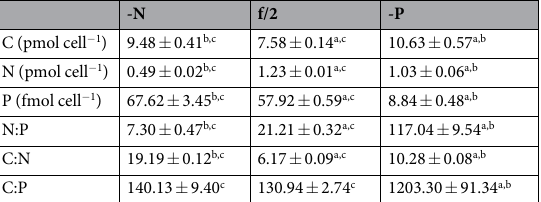
Table 1. Carbon (C), nitrogen (N) and phosphorus (P) contents and molar stoichiometric ratios (N:P, C:N and C:P ratios) of Thalassiosira weissflogii grown in N-limited (-N), nutrient-balanced (f/2) and P-limited (-P) medium. Data are averages with standard deviations. Superscript letters indicate significant differences between nutrient treatments (ANOVA, Fisher LSD post hoc, p <